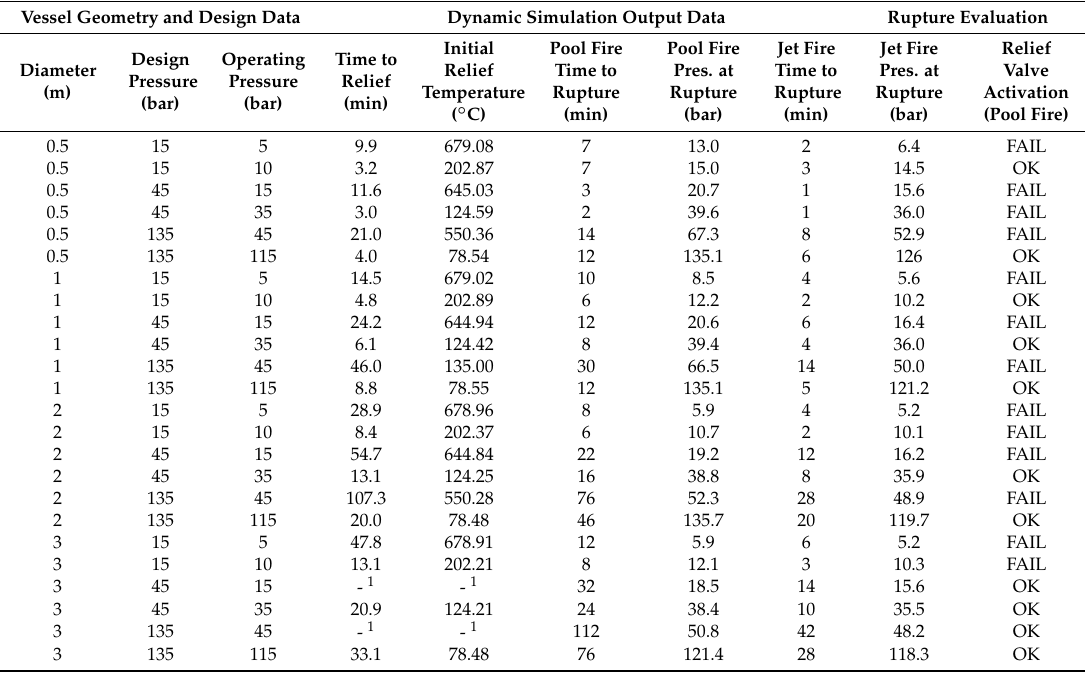
Table 4. Results from the thermomechanical response simulations.